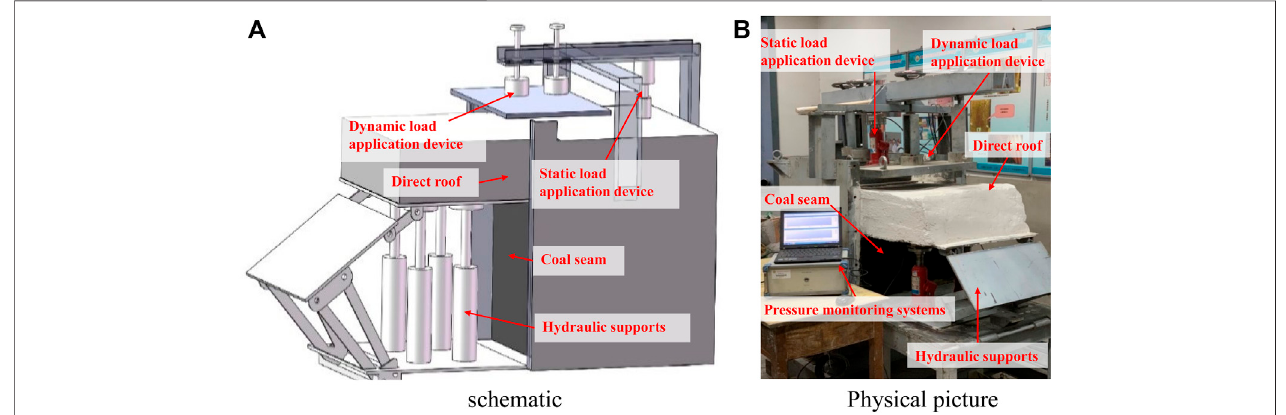
FIGURE 1 | 3D physical modelling platform for the dynamic and static